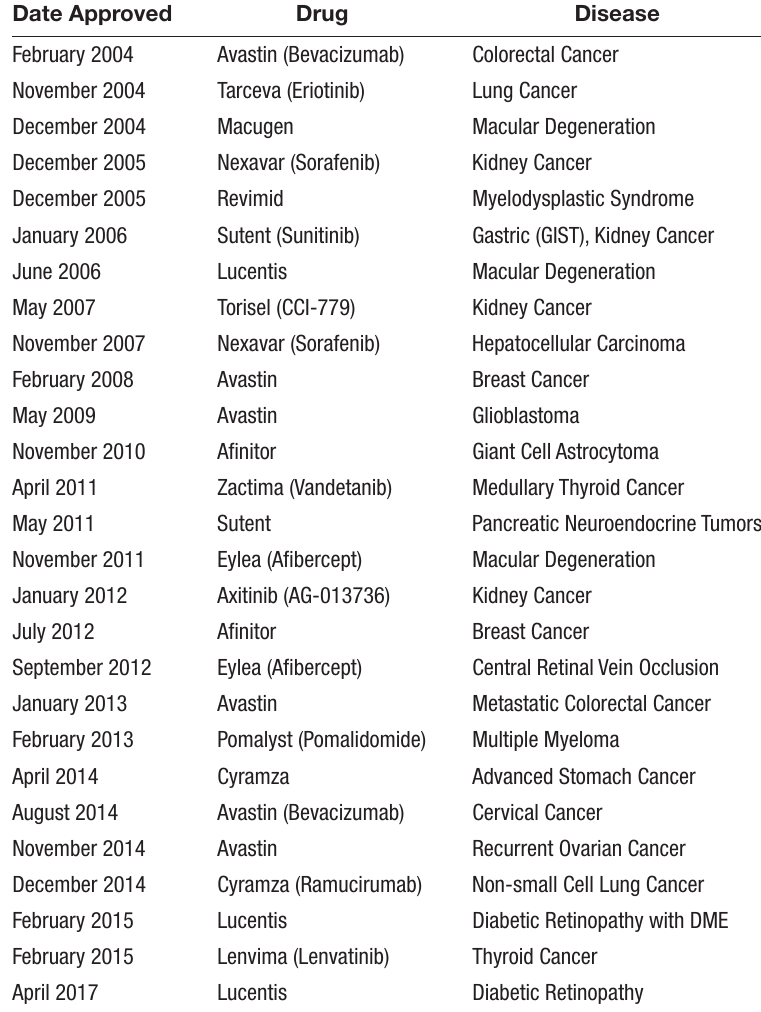
Table 1. Angiogenesis Inhibitors Approved for Clinical Use (Partial List) .